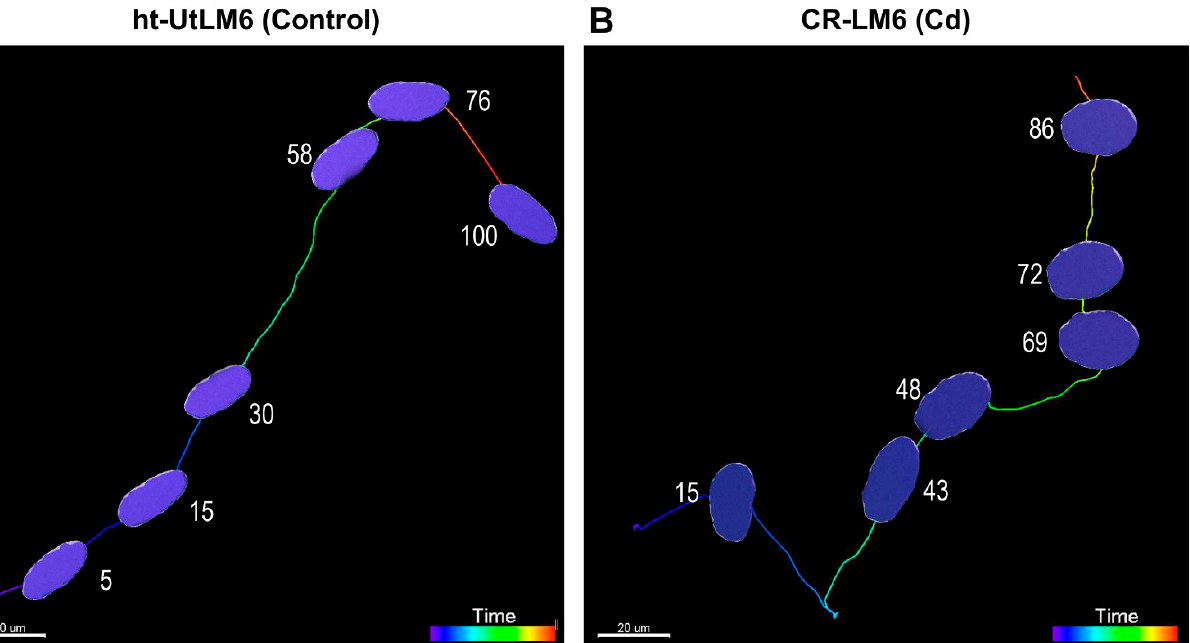
Figure 6. Cd exposure induced rounding of nuclei. ( A ) Shapes of selected nuclei with various C/B ratios from ht-UTLM6 and CR-LM6 populations. The C/B ratio is defined as ratio between the length of the longest principal axis of a nucleus and the length of the second longest principal axis. Scale bar = 15 µm. ( B ) The distribution of C/B ratio in ht-UTLM6. The data labels shown on top of the bars are the absolute counts. ( C ) The distribution of C/B ratio in CR-LM6. ( D ) The overlay of inset B and inset C by probability density function. The x -axis is the C/B ratio and y -axis is probability density.